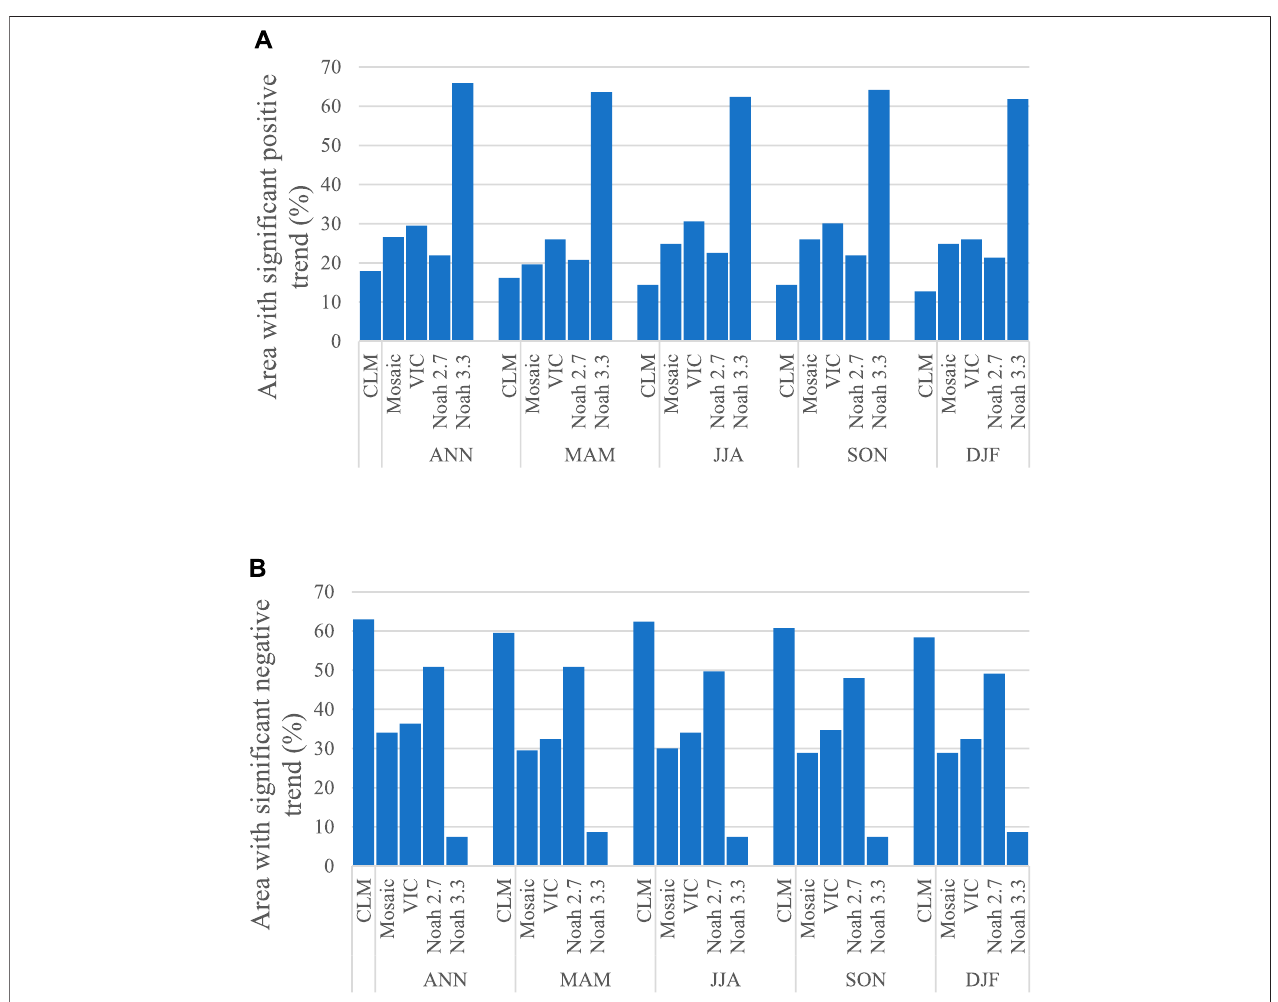
FIGURE 5 | Percentage of areas with signi fi cant positive (A) and negative (B) trends of the fi ve different models at annual and seasonal scales.